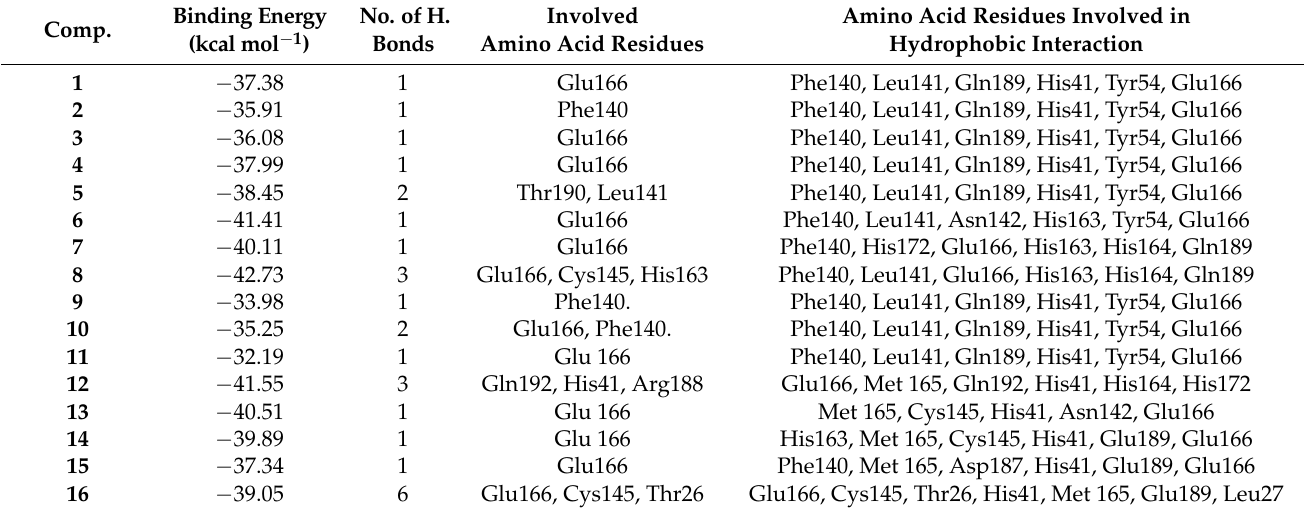
Table 4. Free binding energies of studied isoflavonoids and ligand to coronavirus M pro and amino acid residues involved in H. bonds and hydrophobic interaction.